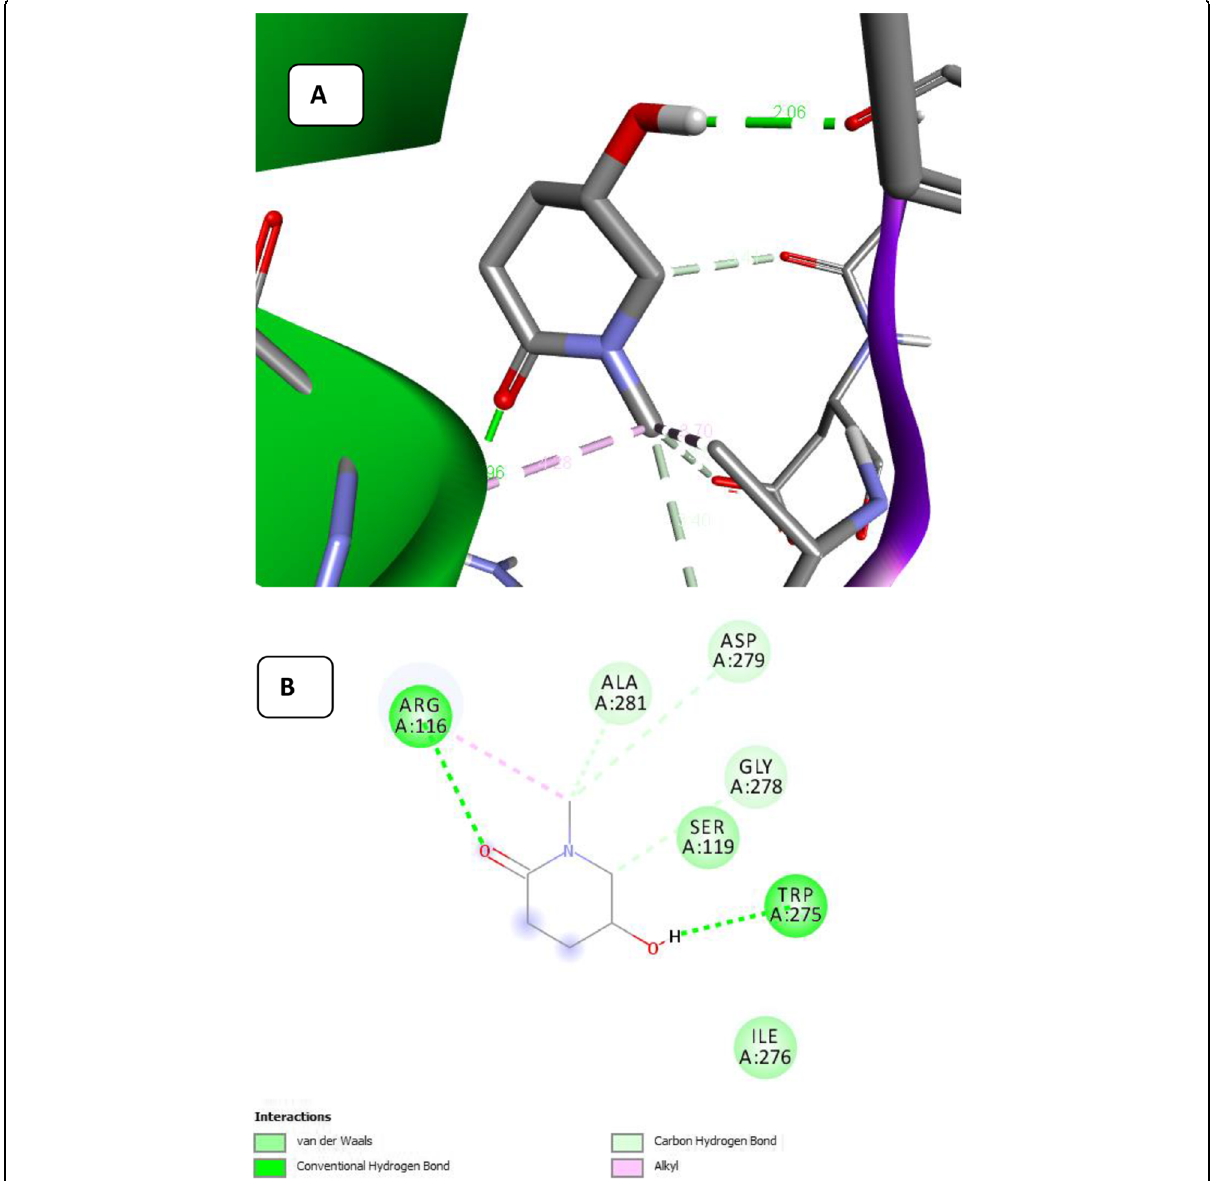
Fig. 9 Best docking conformation with the lowest binding energy. a An interaction on BSA and 5-HMP binding and b Ligplot showing hydrophobic interactions of HSA – 5-HMP in the binding